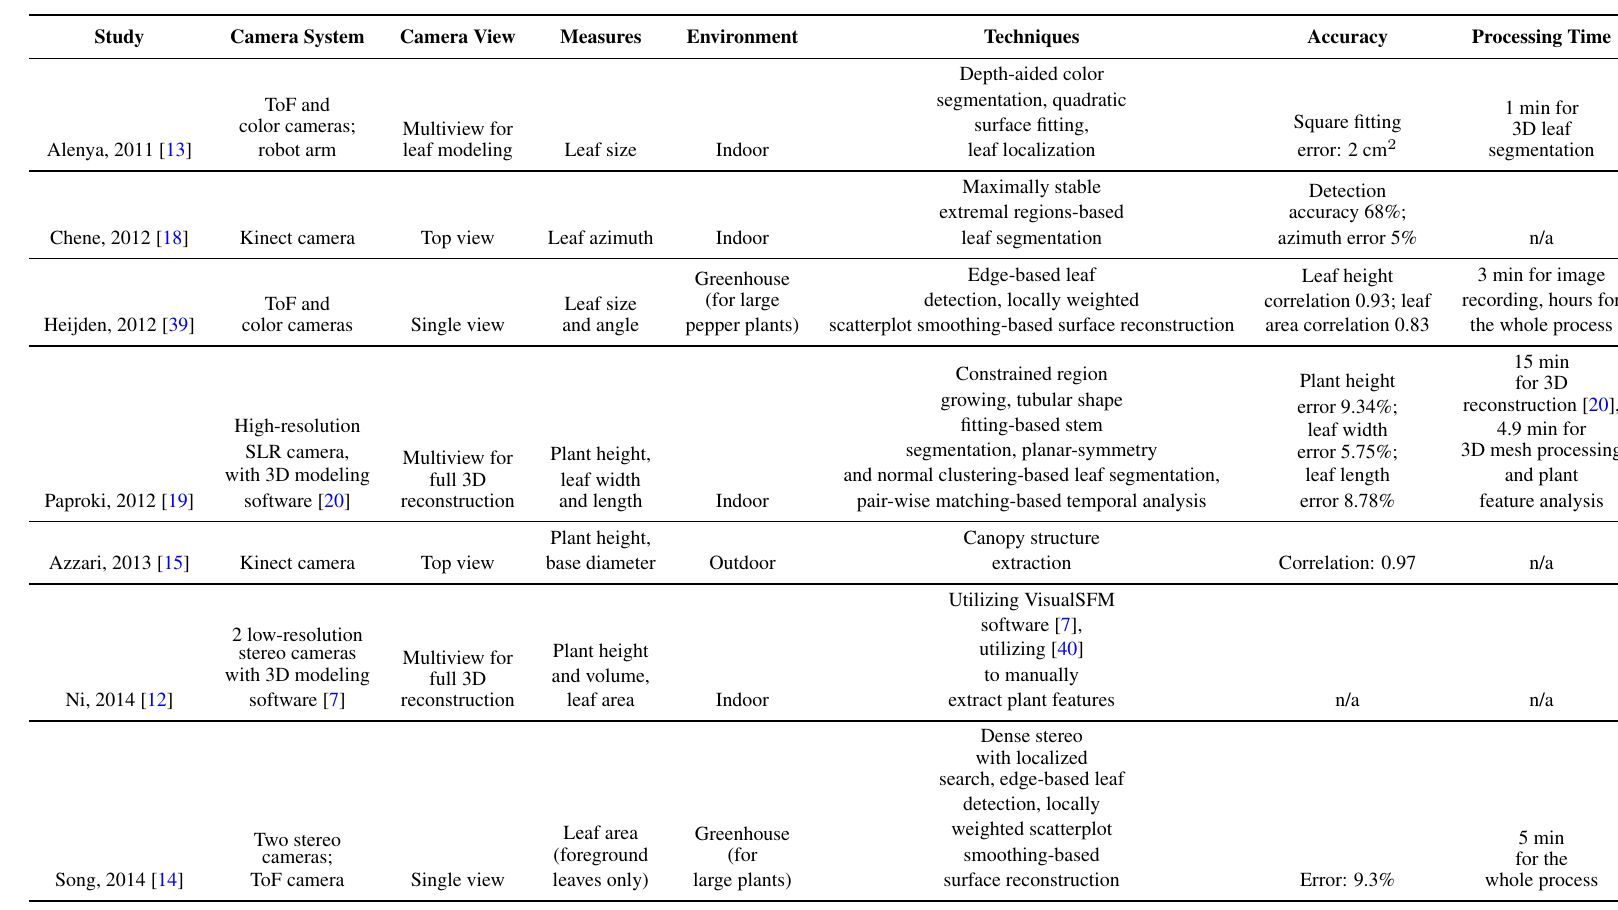
Table 4. Comparison of various camera-based 3D reconstruction systems for